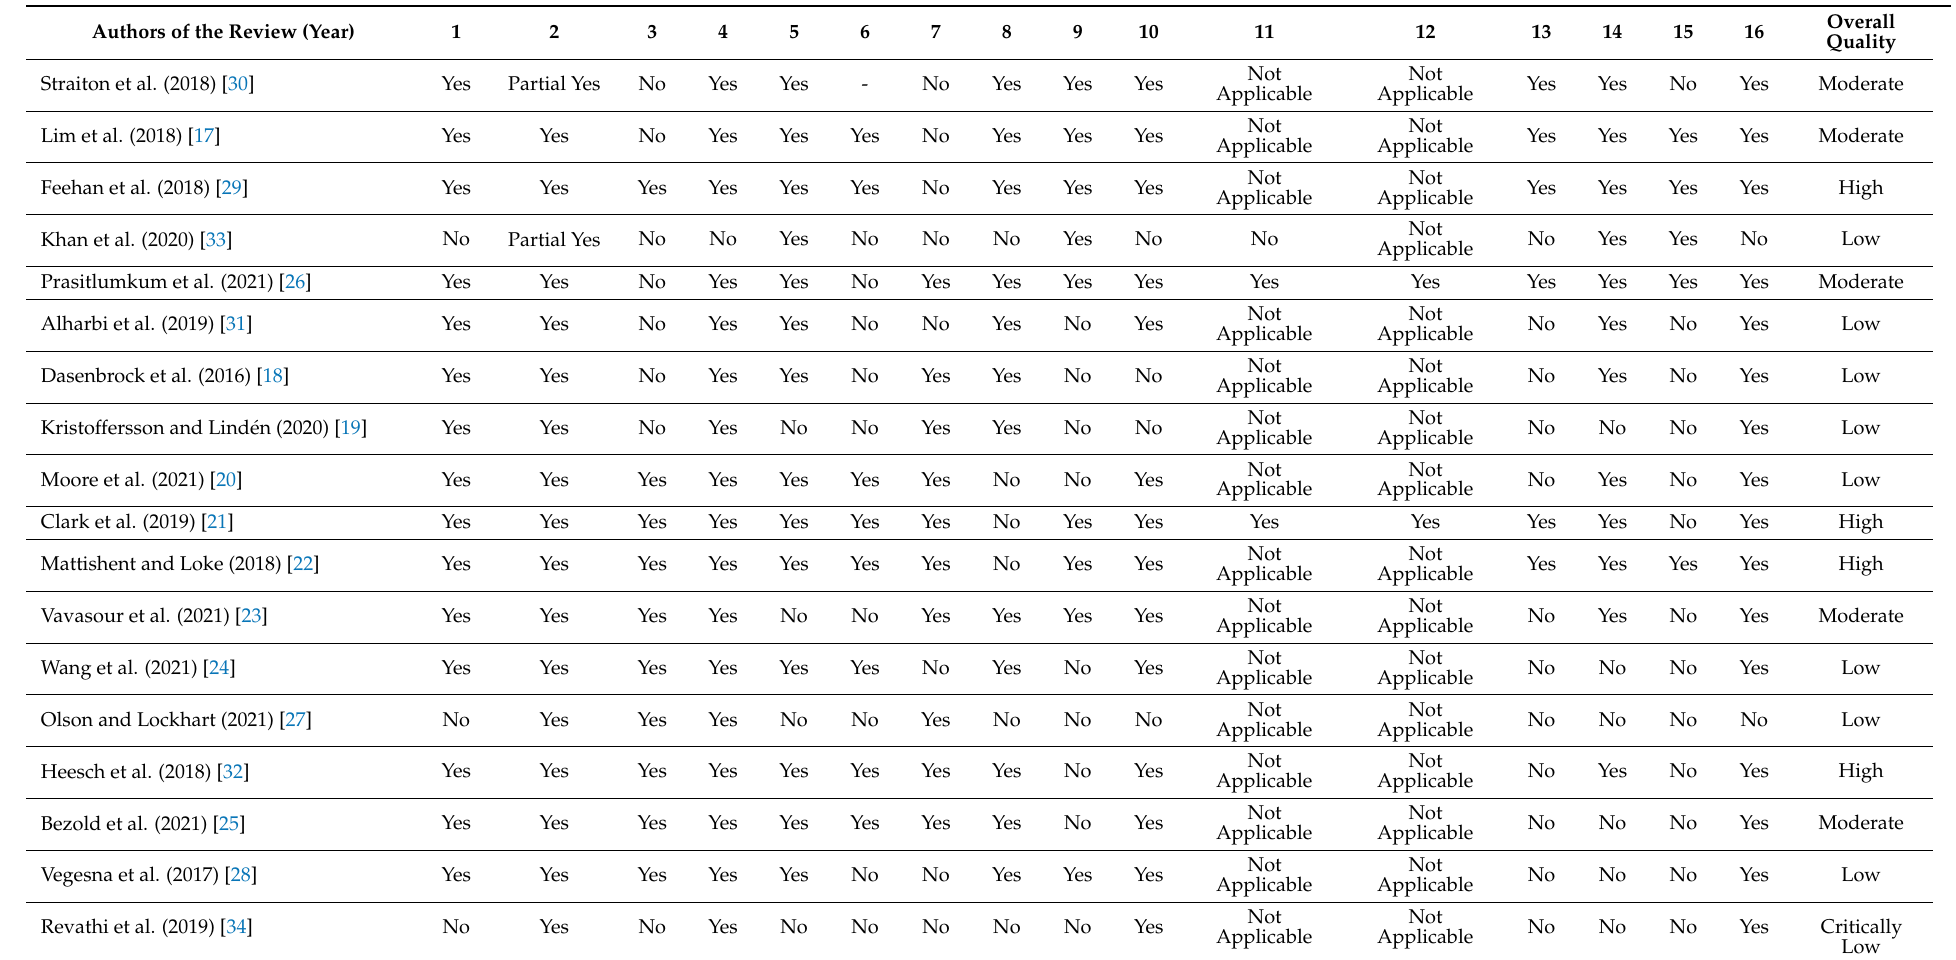
Table 2. Methodological Quality Assessment using AMSTAR